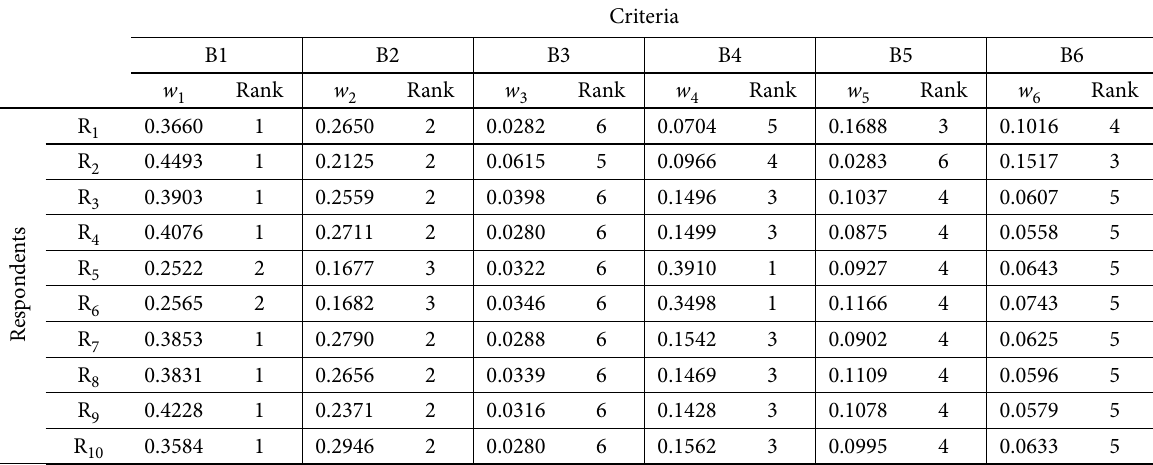
Table 7. The ranks of the sub-criteria sets in B assigned by ten competitive respondents